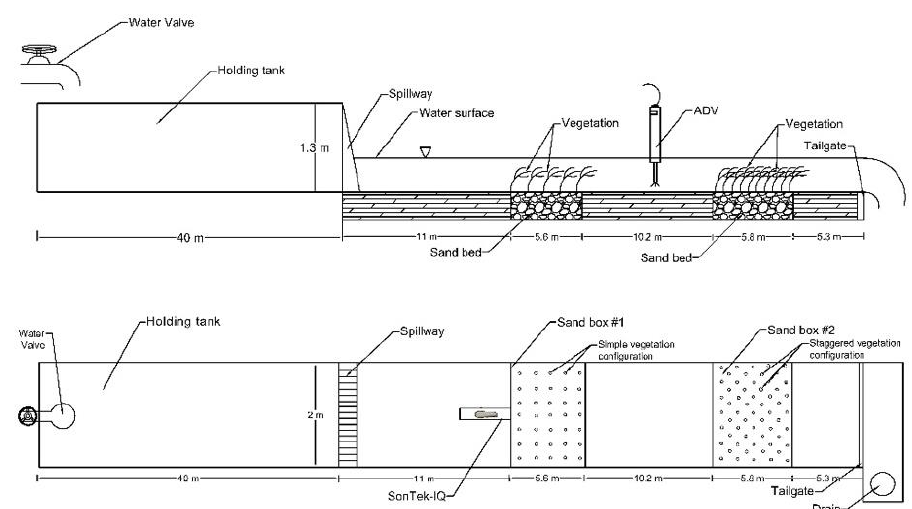
Figure 1. The layout of the experimental flume (vertical and plan views).